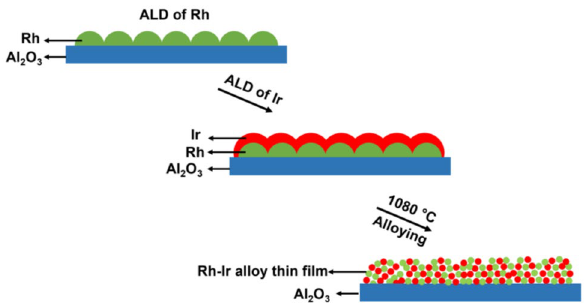
Figure 1. Schematic illustration of the fabrication process of Rh–Ir alloy thin